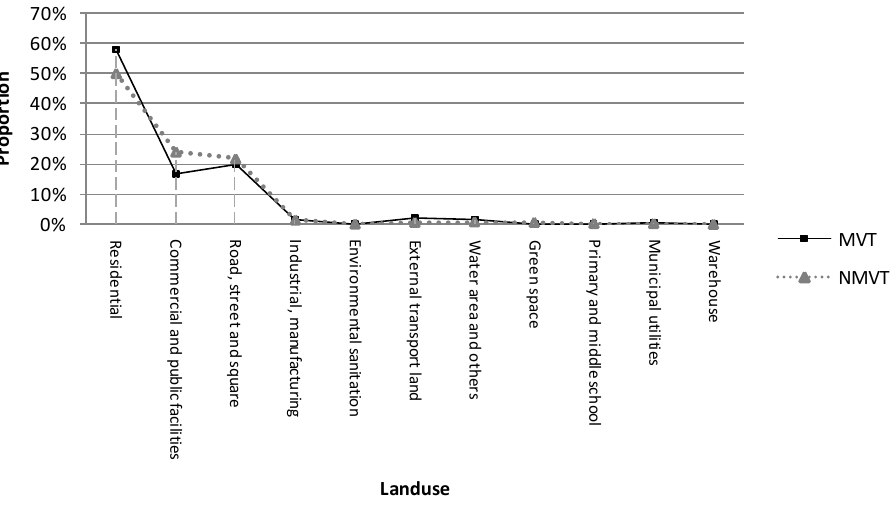
Figure 3. Distribution of vehicle thefts across different types of land use.